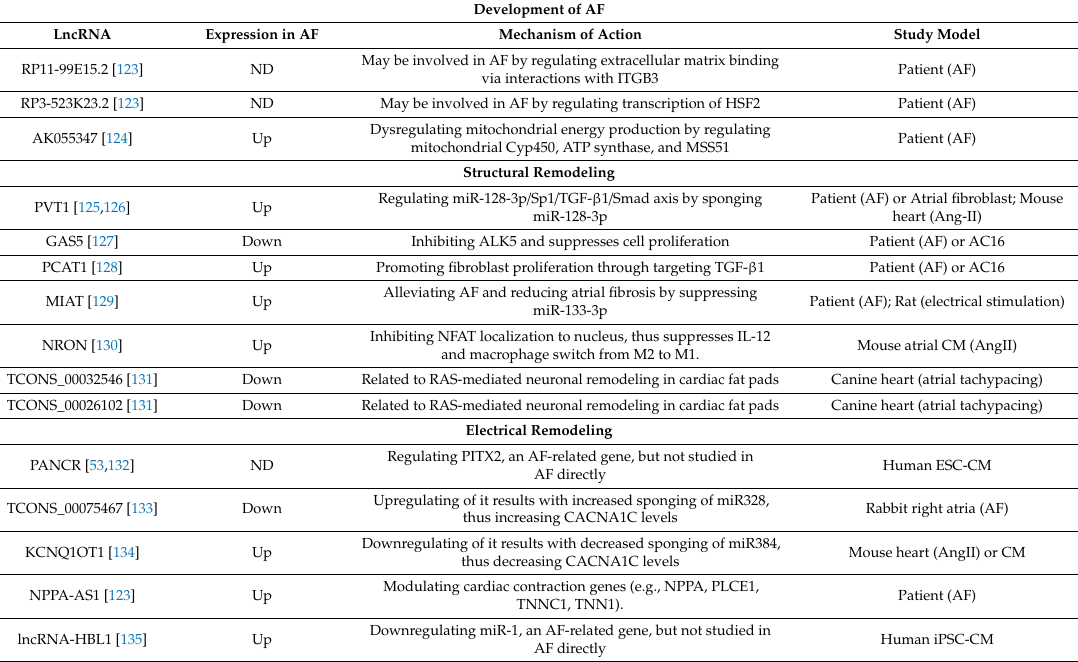
Table 2. LncRNAs in the development and pathophysiological remodeling of